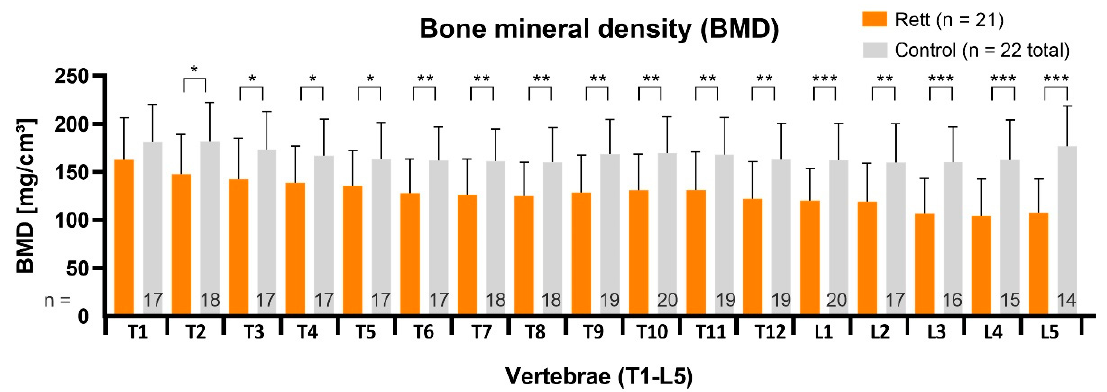
Figure 3. Measurements show a significant reduction of vBMD for all evaluated vertebrae, with statistical difference increasing from upper thoracic ( p < 0.05), to thoracolumbar ( p < 0.01) and lumbar segments ( p < 0.001). The numbers in grey bars represent the total available vBMD values per segment in control group, which vary depending on regions examined in the available CT scans. RTT patients received whole spine scans and the number of values per segment always equals the complete group. T = thoracic vertebra; L = lumbar vertebra. Statistical significance was defined as p < 0.05 (*), p < 0.01 (**) and as p < 0.001 (***).